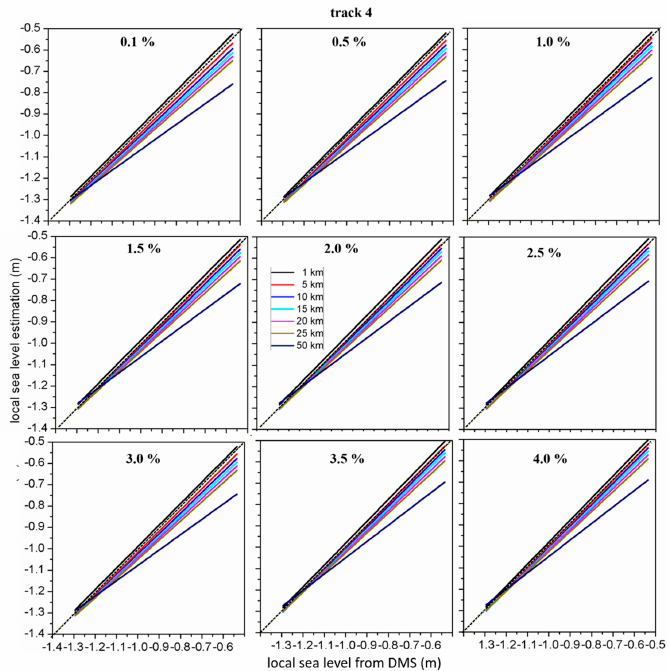
Figure 6. Linear fit lines of track 4 between retrievals from the lowest elevation method and those from the DMS method (ground truth) at 7 segment length scales: 1, 5, 10, 15, 20, 25, and 50 km, and 9 percentage scales: 0.1%, 0.5%, 1%, 1.5%, 2%, 2.5%, 3%, 3.5%, and 4%. The dashed line is the 1:1 line. All linear least square fits are statistically significant with greater than 95% confidence using an F test. Remote Sens. 2020 , 12 , x FOR PEER REVIEW